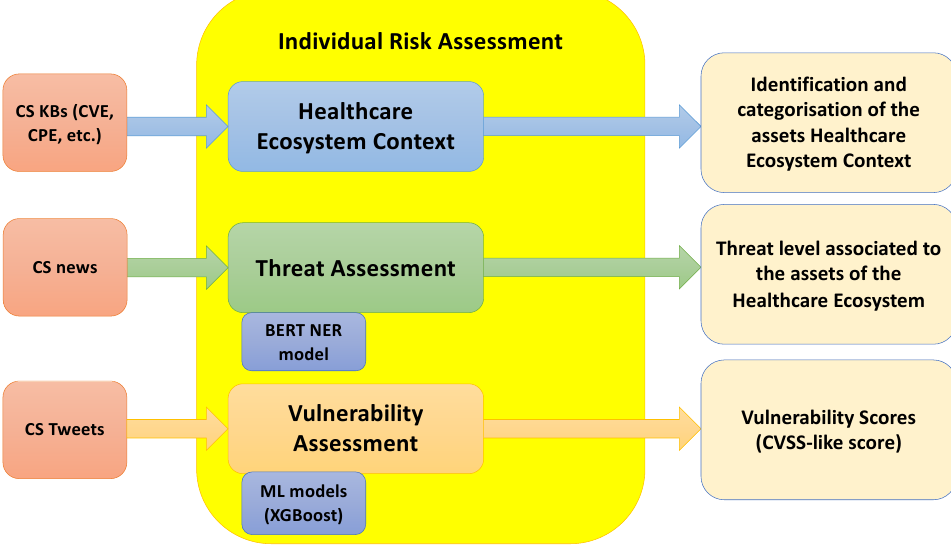
Figure 1. Individual Risk Assessment methodology